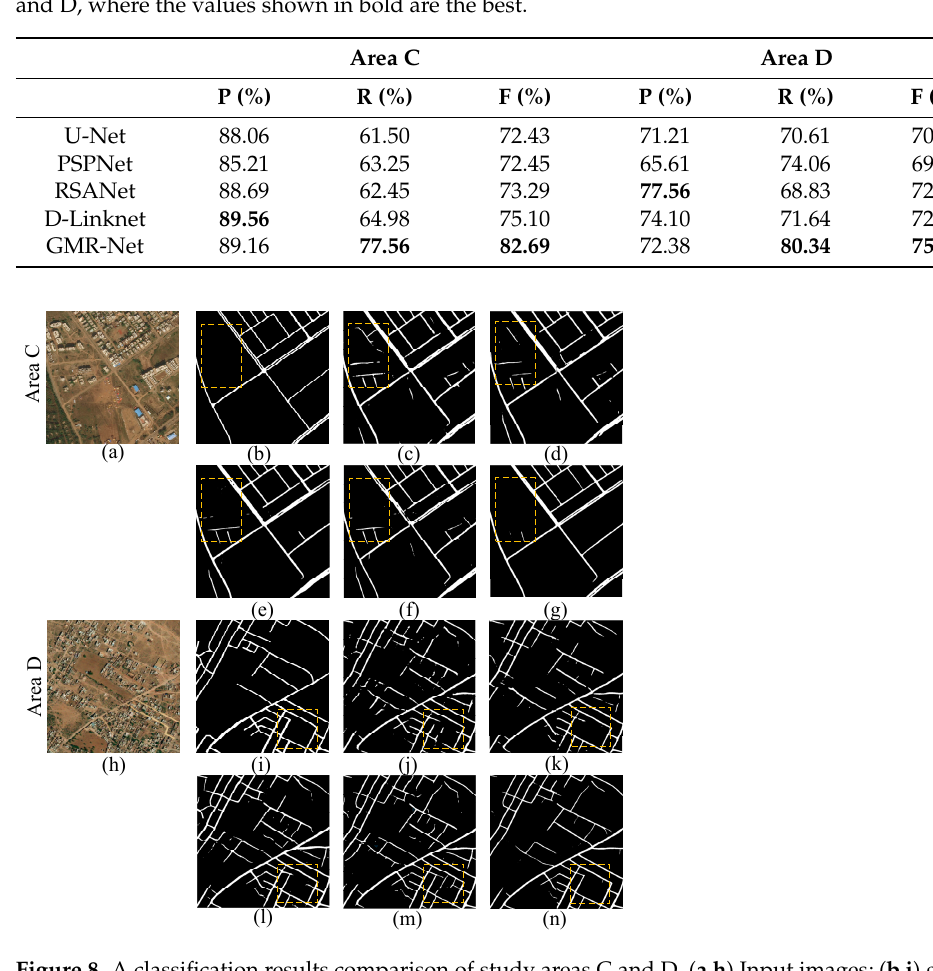
Figure 8. A classification results comparison of study areas C and D. ( a , h ) Input images; ( b , i ) ground truth; ( c , j ) U-Net; ( d , k ) PSPNet; ( e , l ) RSANet; ( f , m ) D-Linknet; and ( g , n ) GMR-Net. The position of the yellow-dashed frame indicates areas where false judgment occurs. Table 6. A results comparison between the GMR-Net method and other methods in research areas C and D, where the values shown in bold are the best.